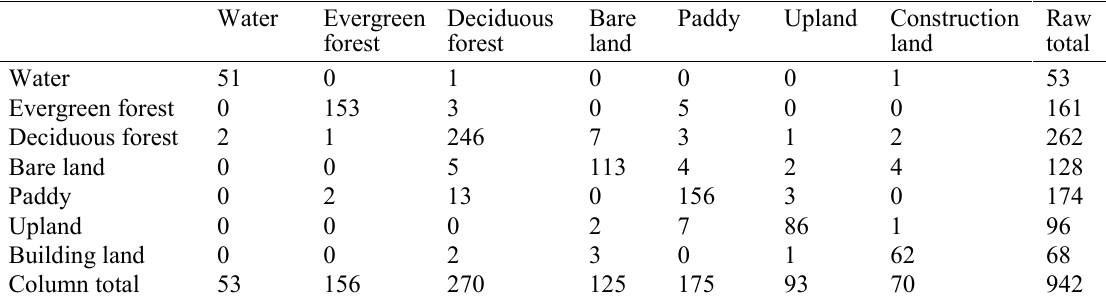
Table 2 Accuracy assessment of land-use classification.